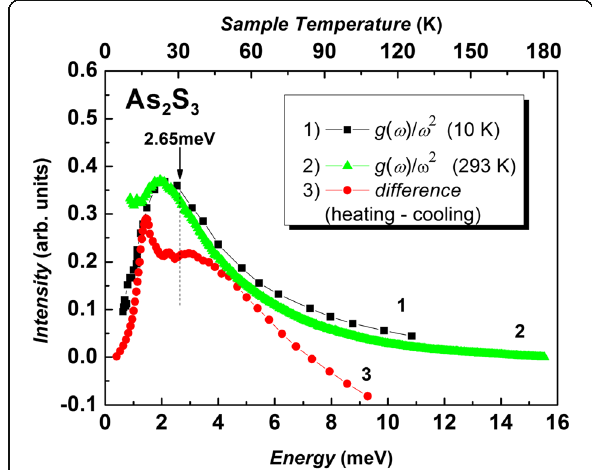
Fig. 5 Density of states g ( ω ) in representation g ( ω )/ ω 2 estimated from measured low-frequency (LF) Raman spectra at 10 K taken from [11] ( curve 1 ); g ( ω )/ ω 2 from own LF Raman spectra measured at room temperature (293 K) ( curve 2 ) and difference curve k ( T ) between cooling k ( T ) and heating k ( T ) cycles (see Fig. 4) ( curve 3 ). ( Color online